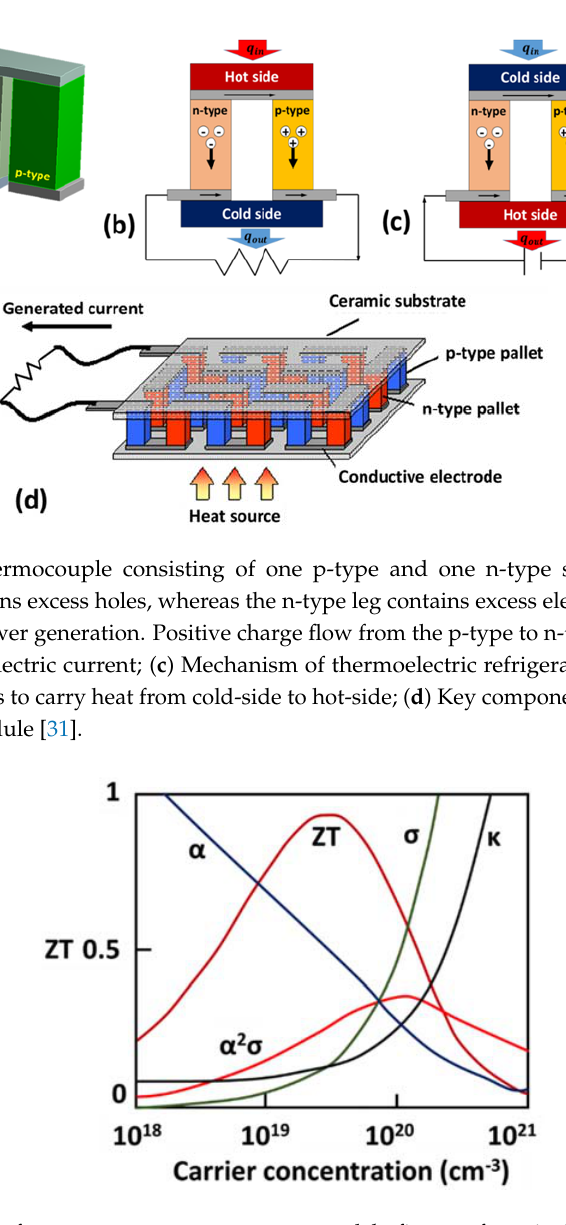
Figure 5. Variation of transport parameters: α , σ , and k , figure of merit, ZT, power factor, α 2 σ , as a function of carrier concentration for bismuth telluride. Figure redrawn from reference [33]. The electrical and thermal conductivities, σ and k , increase with an increase in carrier concentration, while the Seebeck coefficient, α , decreases with an increase in carrier concentration. This indicates that maximizing ZT requires optimization of α , σ , and k , simultaneously.